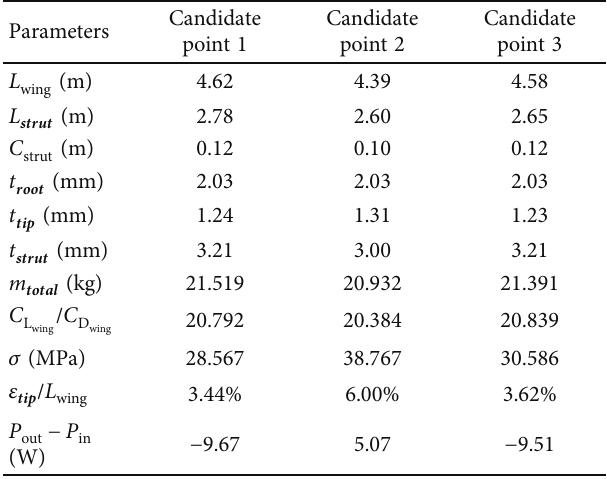
Table 6: Candidate points.